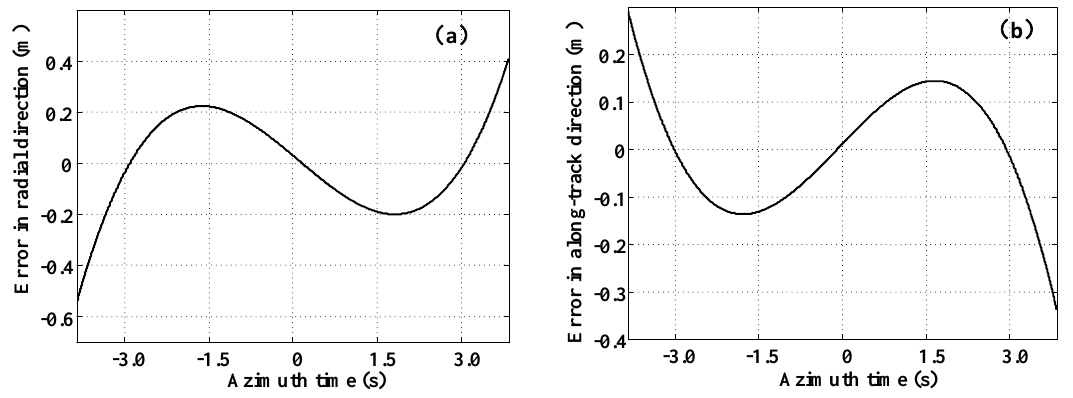
Figure 5. Simulated motion errors in the ( a ) radial direction and ( b ) along-track direction.